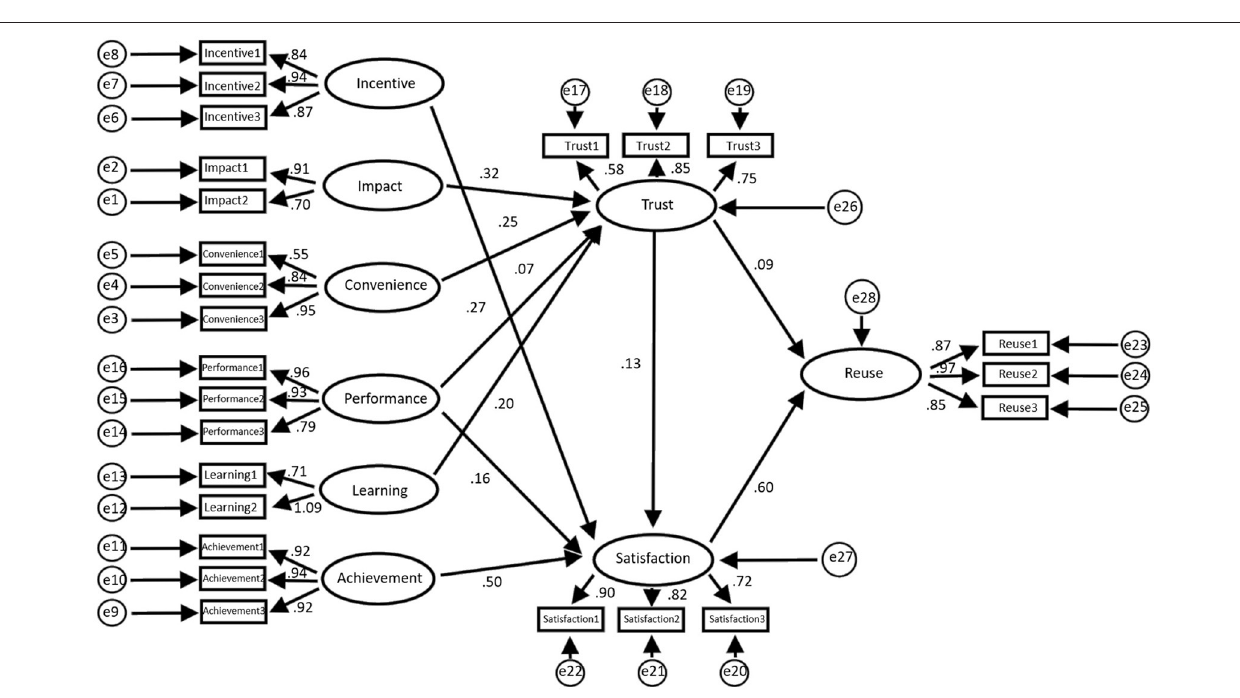
FIGURE 10 | Before